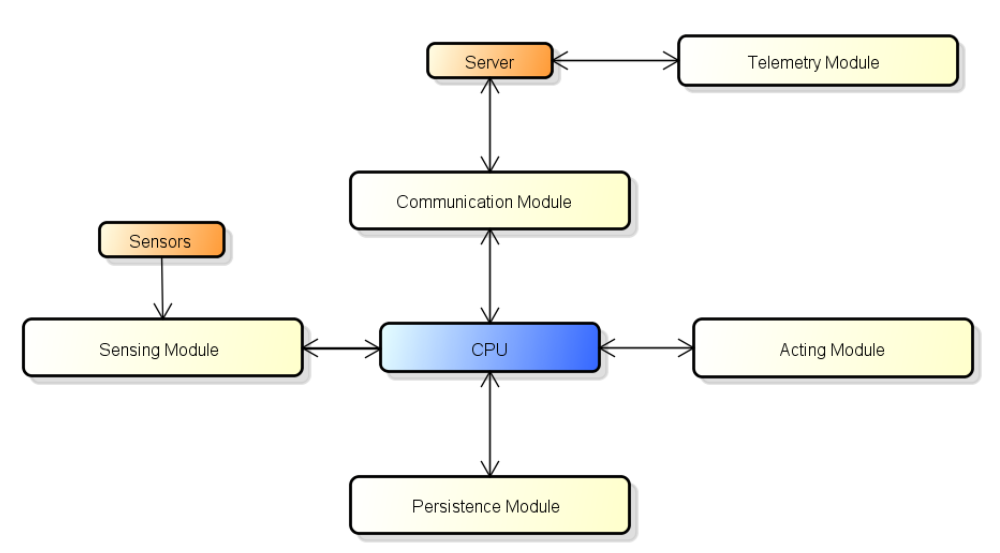
Figure 4. High-level hardware